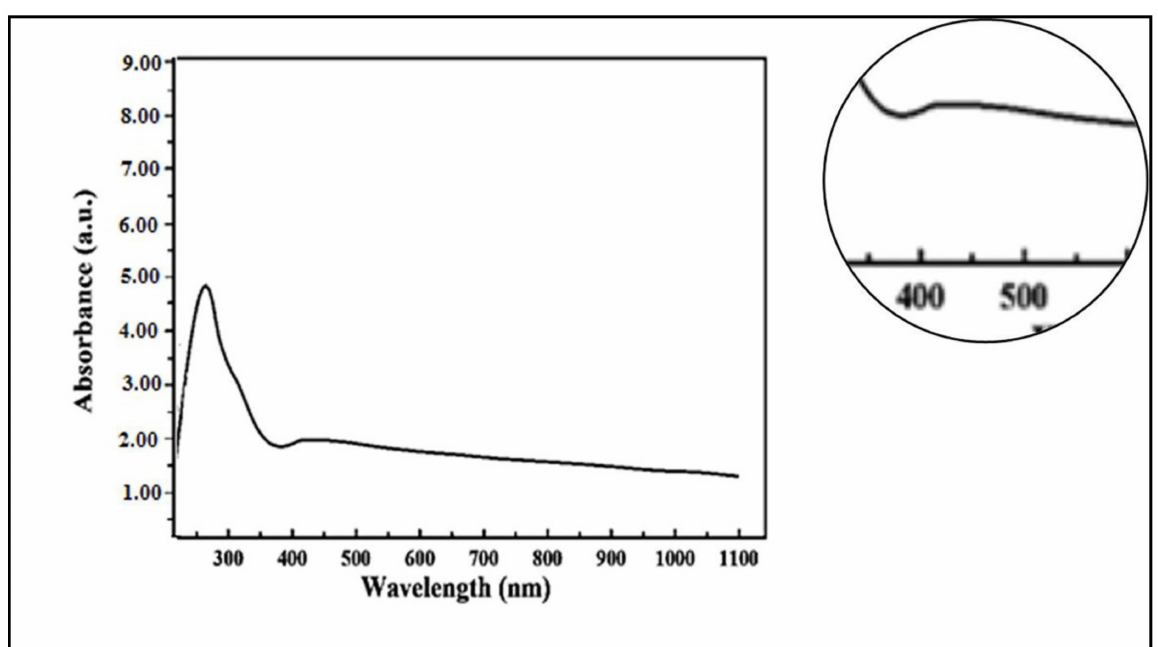
Figure 1. UV–vis spectra of silver nanoparticles synthesized using C. acutum latex extract (Cy-AgNPs); initial AgNO 3 concentration, 1 mM.